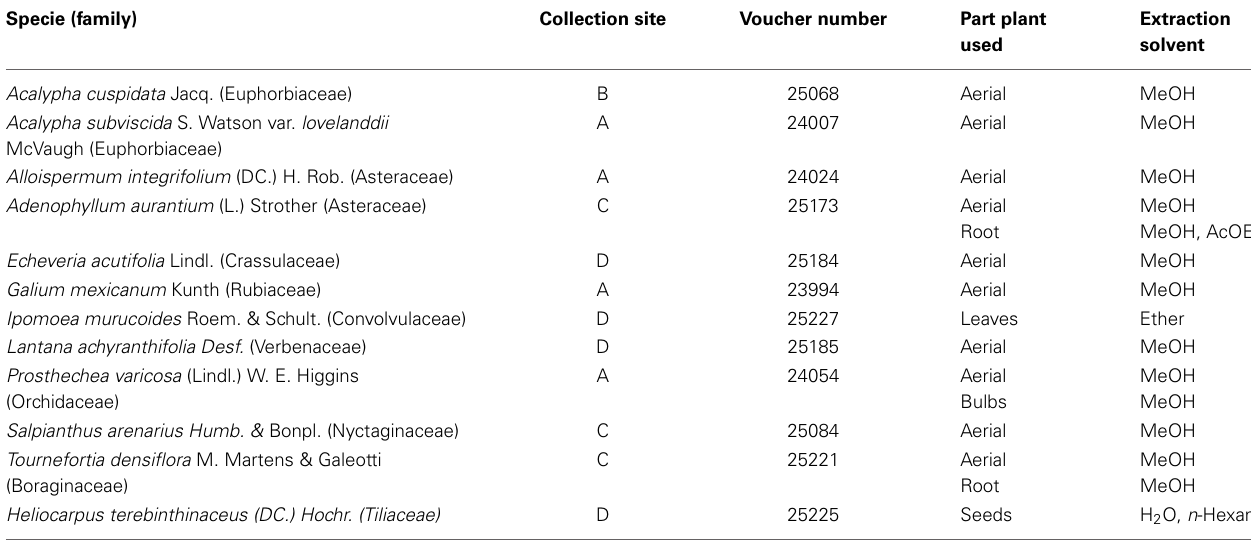
Table 1 | Plants from Oaxaca evaluated against the phytopathogen fungi Fusarium solani and Alternaria alternata . Specie